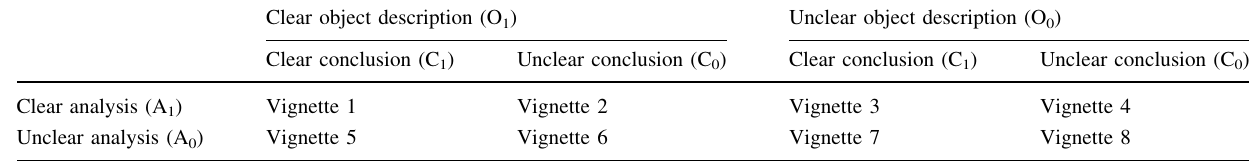
Table 1 Combinations and coding of vignettes